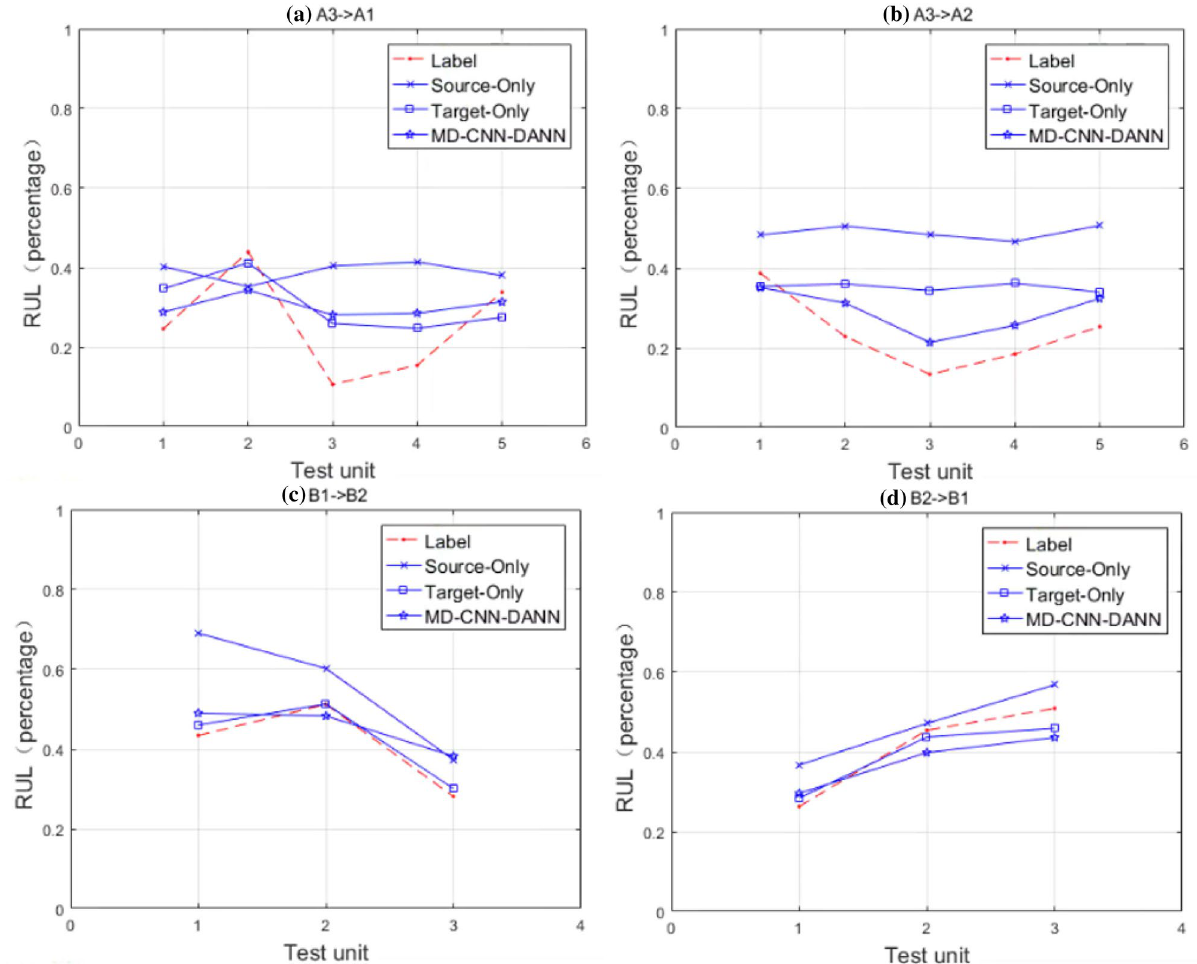
Figure 5. RUL estimation comparisons with source-only and target-only methods on FEMTO and XJTU-SY datasets. ( a ) E5: A3 −→ A1, ( b ) E6: A3 −→ A2, ( c ) E7: B1 −→ B2, ( d ) E8: B2 −→ B1.